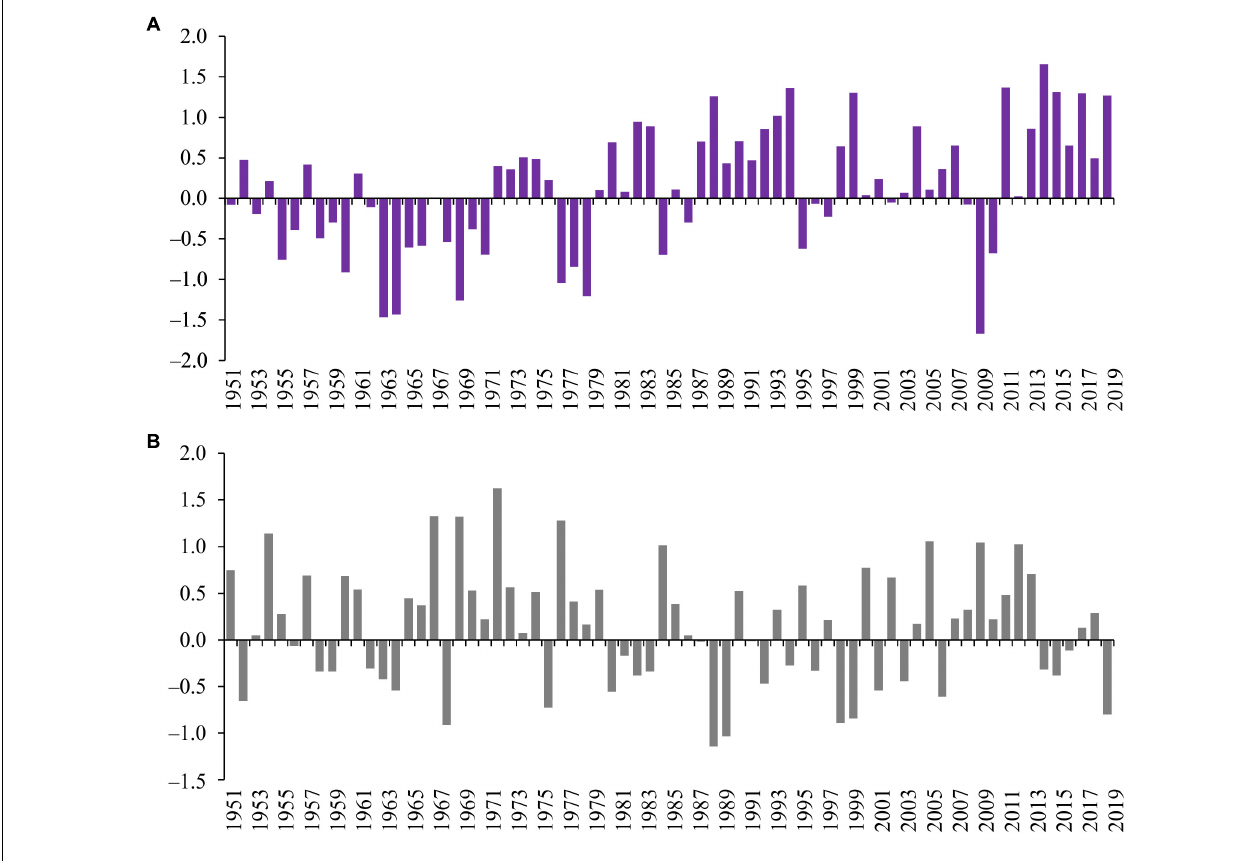
FIGURE 5 | Winter averaged values of the North Atlantic Oscillation (A) and Scandinavia (B) indices from 1951 to 2020 (calculated according to NOAA data, 2021).